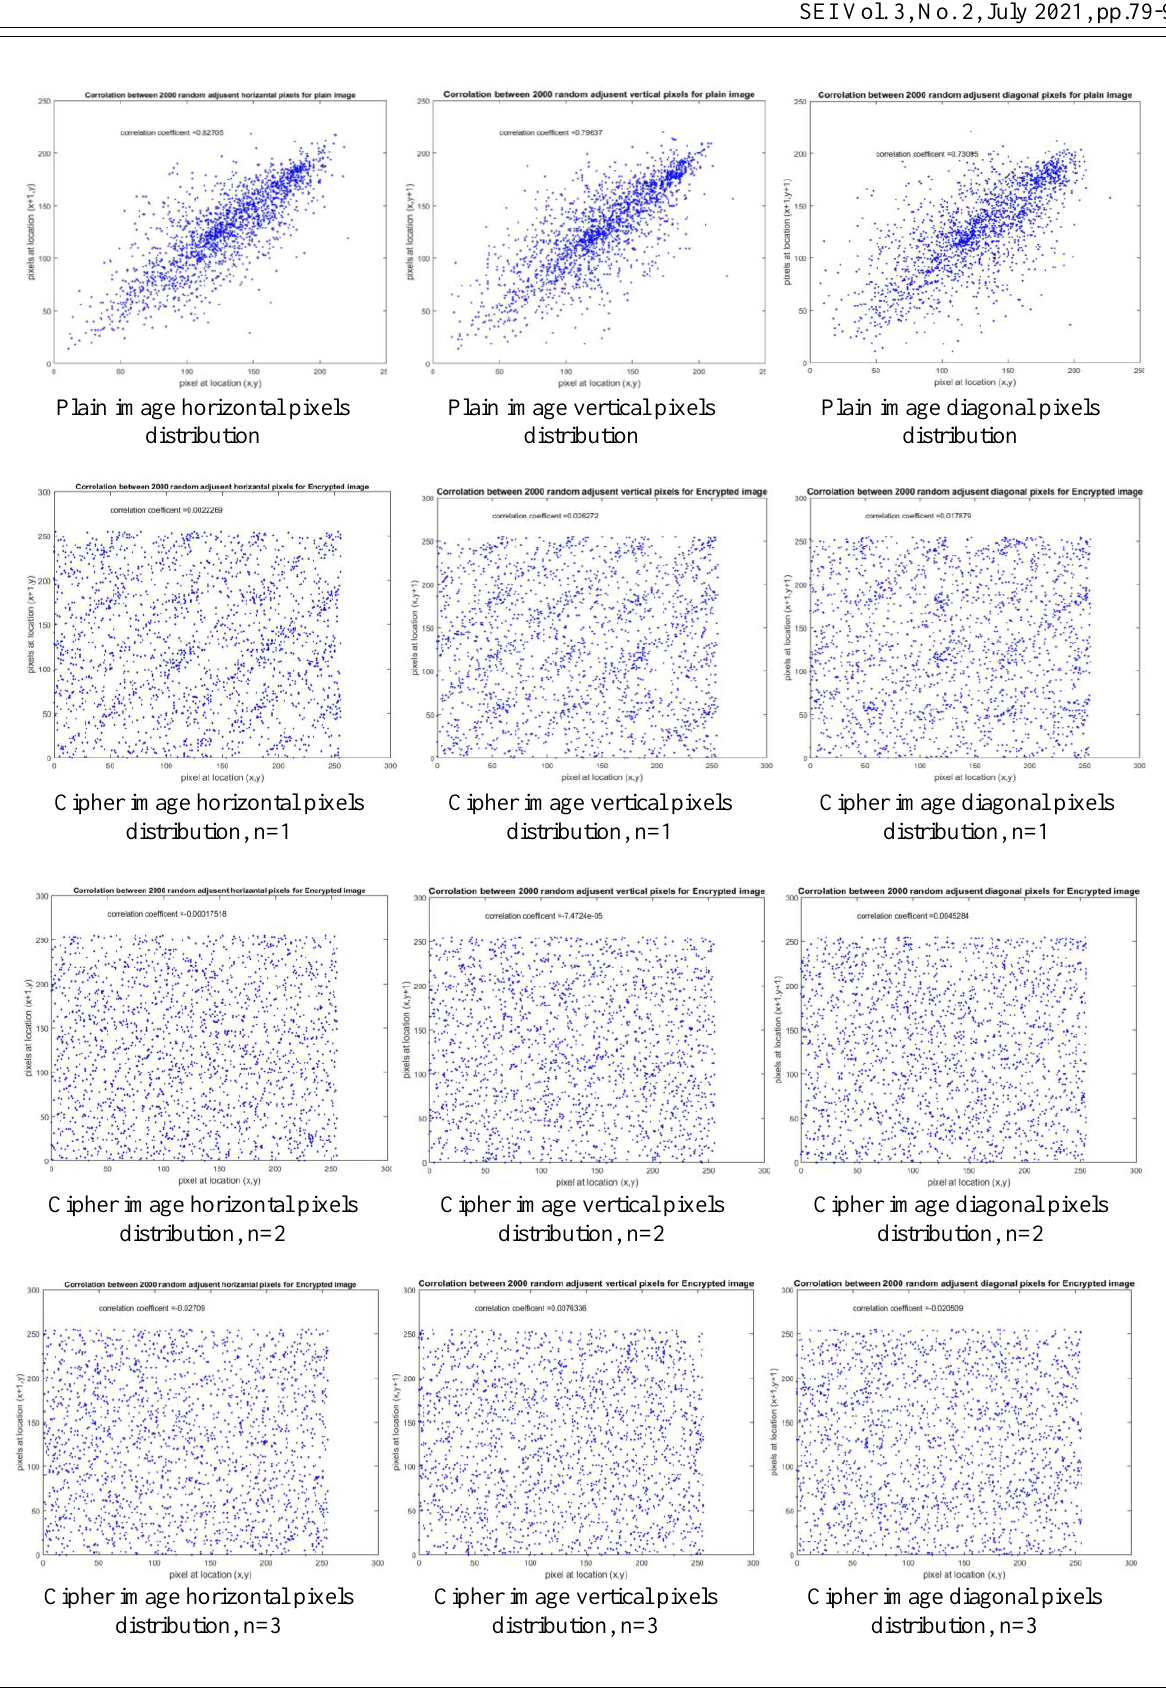
Figure 8. The distribution of the adjacent pixels of the plain and the cipher images of "Mandrill.png" Both of NPCR and UACI tests are computed between two cipher images of the same plain image but with one-pixel value difference. The values of NPCR and UACI, listed in Table 6, are far from the ideal